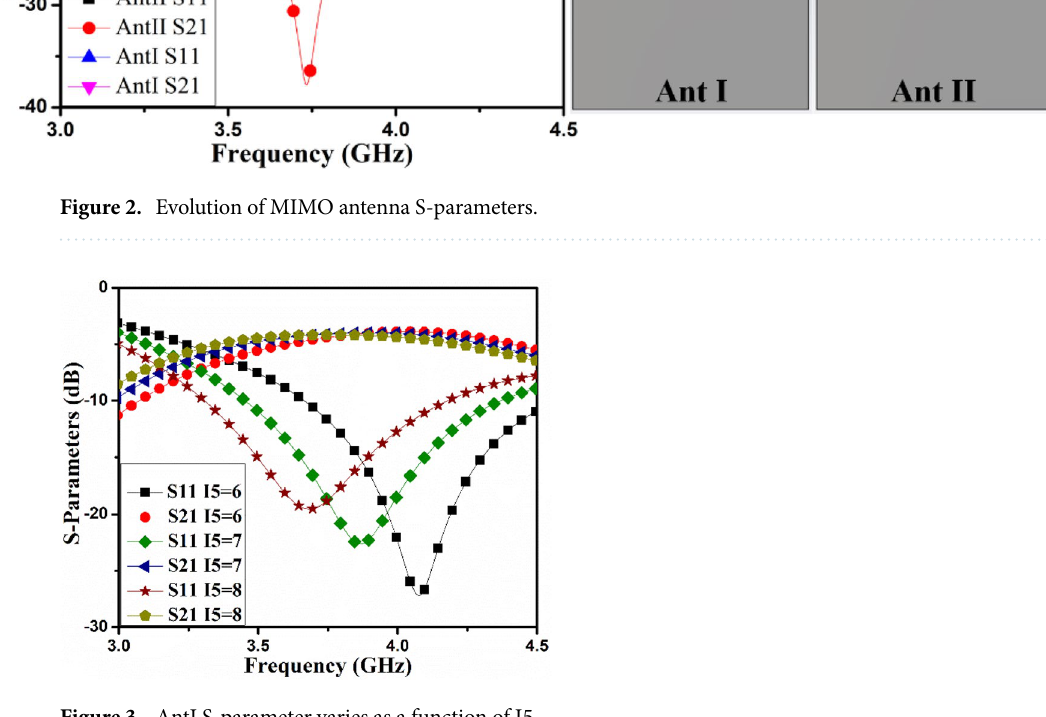
Figure 3. AntI S-parameter varies as a function of I5.